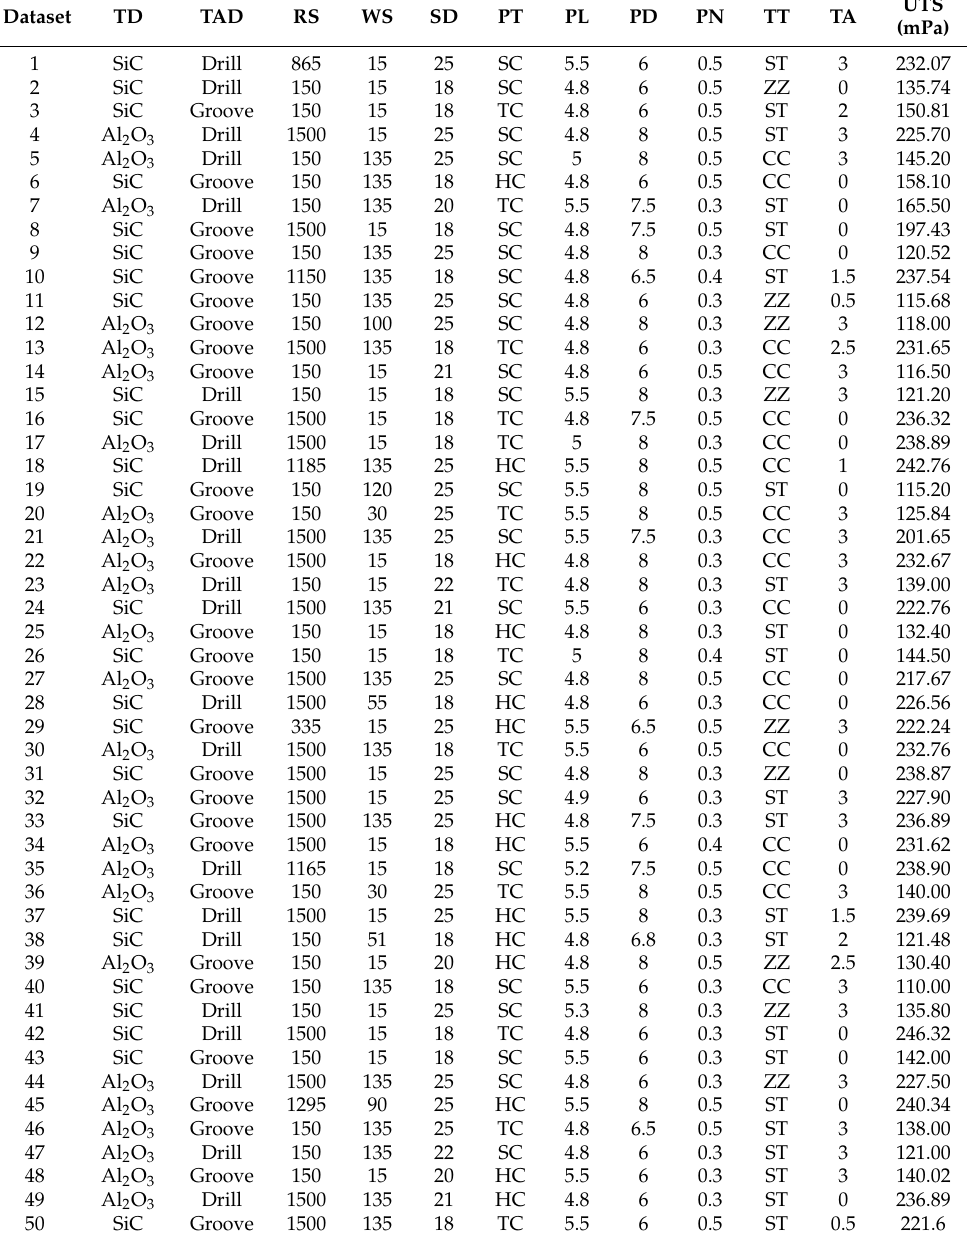
Table 10. Details of the 11PI-V1-60